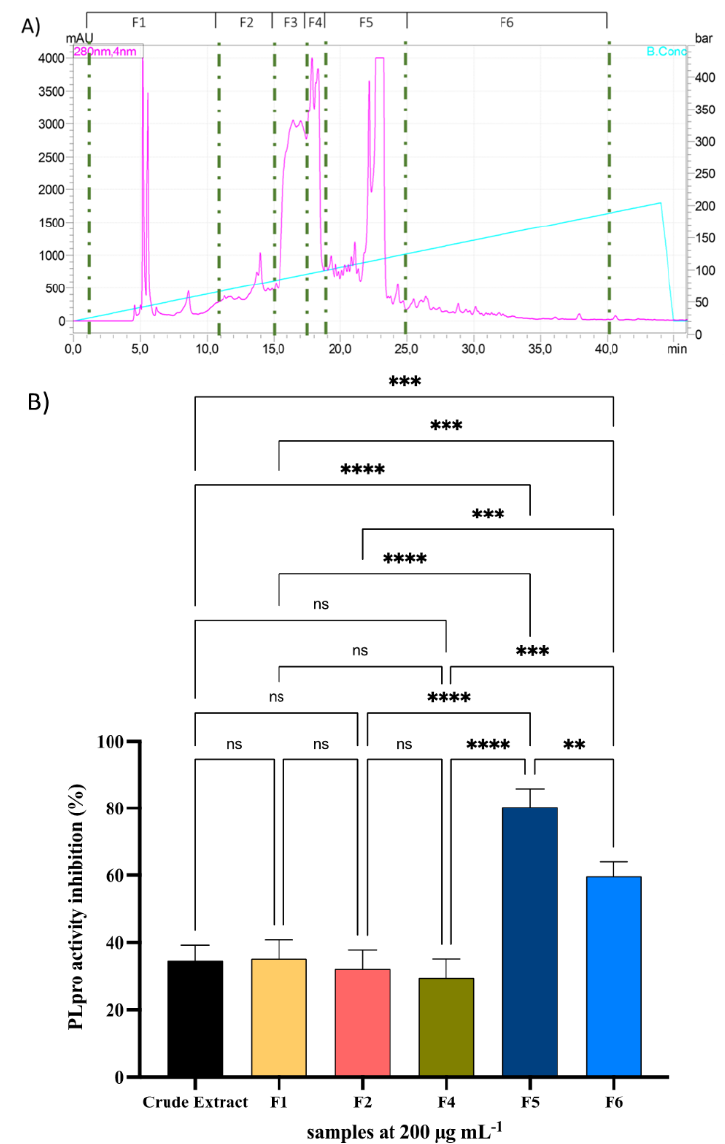
Figure 1. Chromatographic conditions for the fractionation of flavonoids in green tea extract ( A ) PLpro inhibitory effect of the crude extract and fractions F1, F2, F4, F5, and F6. ( B ) Bars represent the mean ± s.d. of three independent experiments performed in triplicate. Data were analyzed by one-way ANOVA followed by Tukey post hoc test. ns: not significant, ** p < 0.1, *** p < 0.001; **** p < 0.0001.